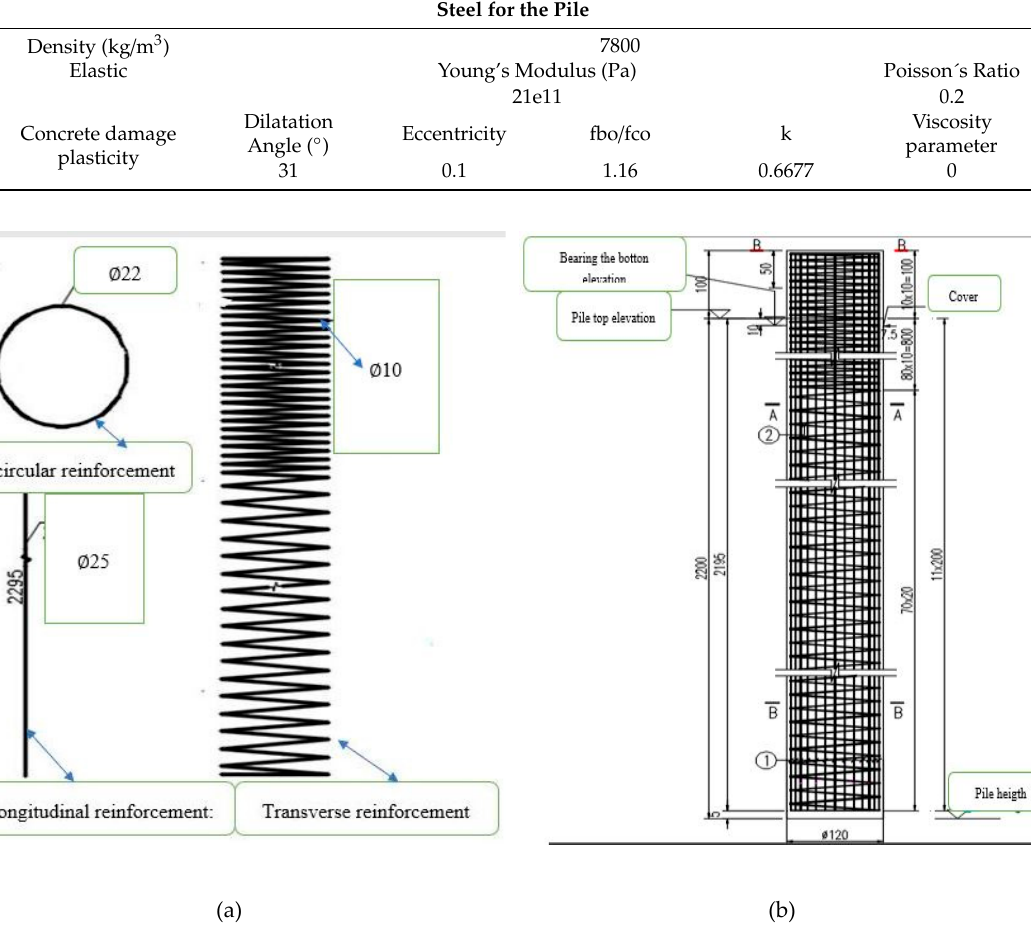
Figure 4. Modeling of the steel used for analysis the pile, ( a ) the detail of rebar used in Abaqus ™ , ( b ) Cover and reinforcement of the pile in which the concrete would be poured.